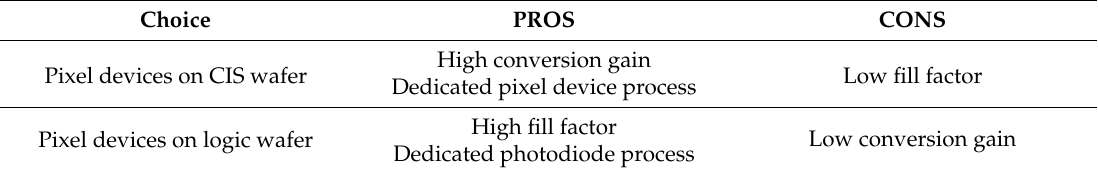
Table 1. Pros and cons of two different methods of pixel device placement.